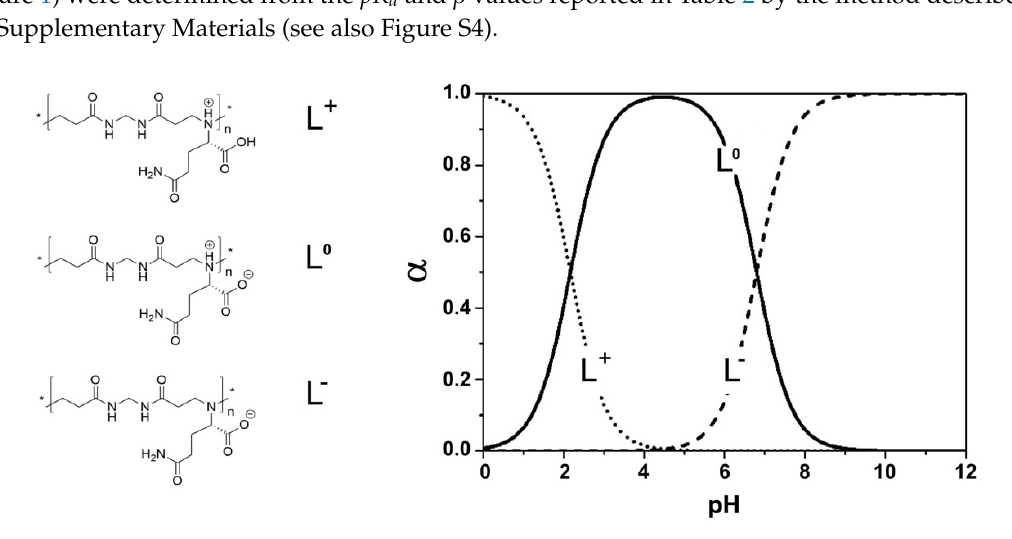
Table 2. pK a and β values of M- L -Gln in the α range 0.2-0.8 ( β 1 ) and 0.1-0.9 ( β 2 ). a